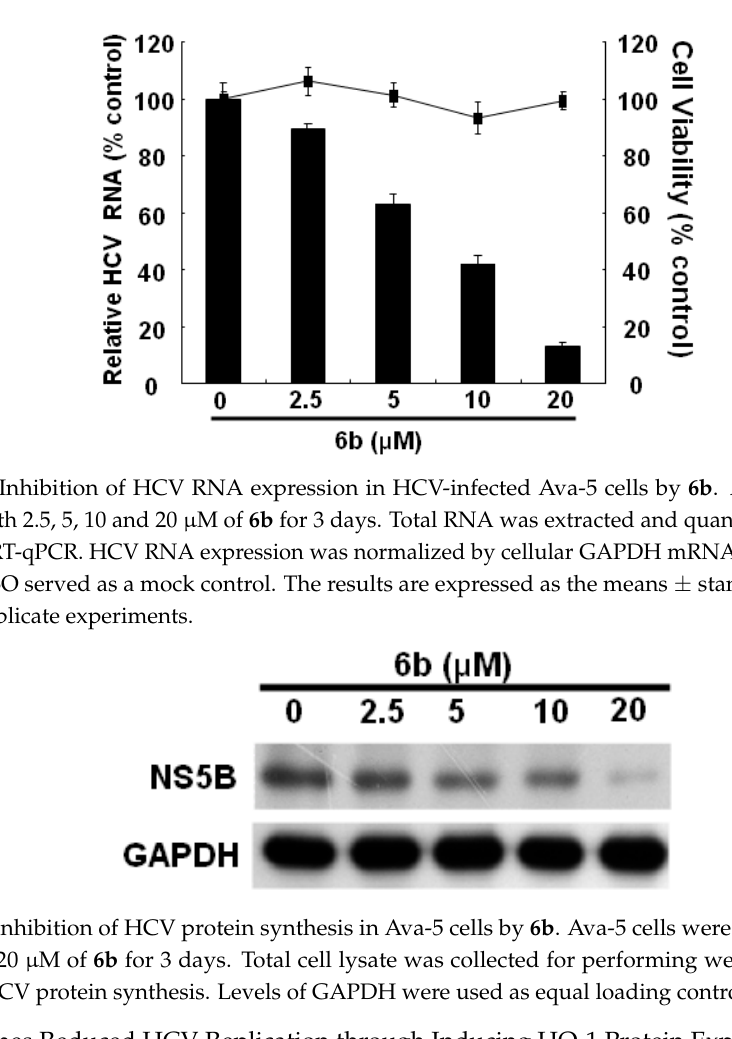
analyze HCV protein synthesis. Levels of GAPDH were used as equal loading control.